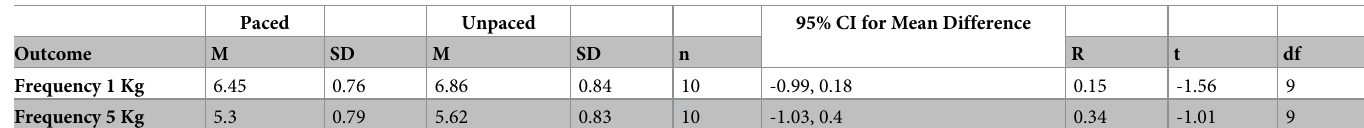
Table 4. Paired t -test results for paced and unpaced tasks.